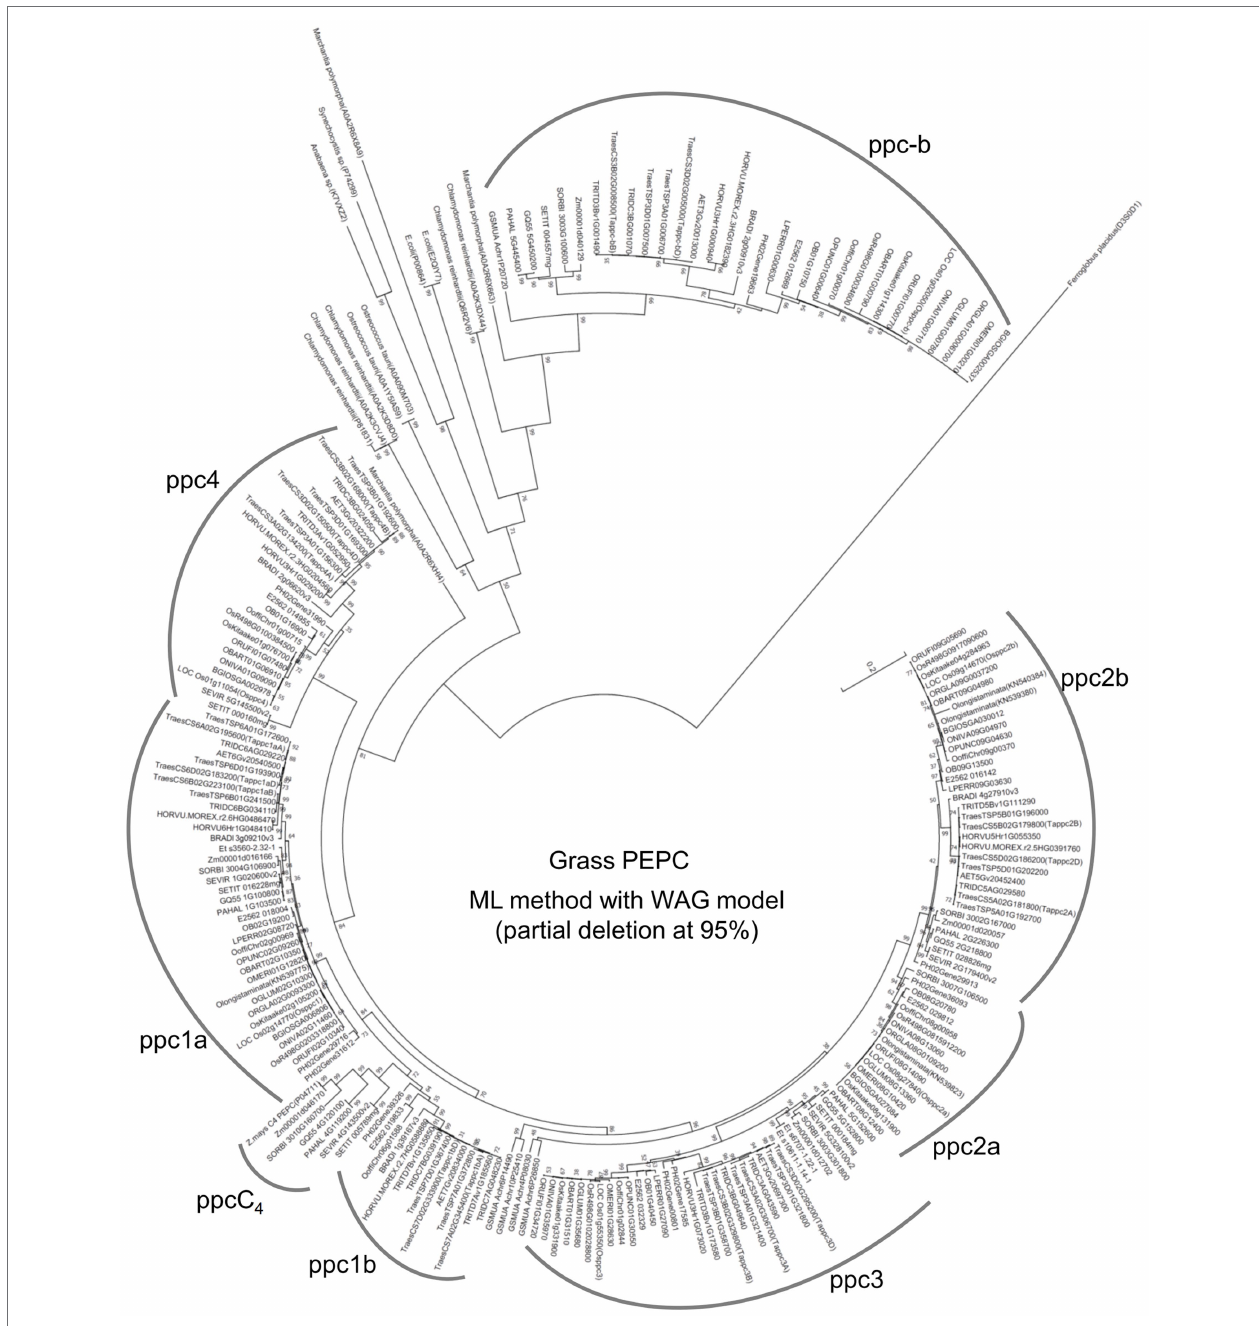
FIGURE 2 | An maximum likelihood (ML) phylogenetic tree dissects grass PEPC proteins. Out-grouped PEPCs were shown as follows; Chlamydomonas reinhardtii (P81831, A0A2K3CVJ4, A0A2K3D8D0, Q6R2V6, and A0A2K3DX44), Ostreococcus tauri (A0A1Y5IAS9, A0A090M703), Anabaena sp. (K7VXZ2), Synechocystis sp. (P74299), Marchantia polymorpha (A0A2R6X663), Escherichia coli (P00864, E2QIY7), and Ferroglobus placidus (D3S0D1). The log likelihood for this tree was “ −